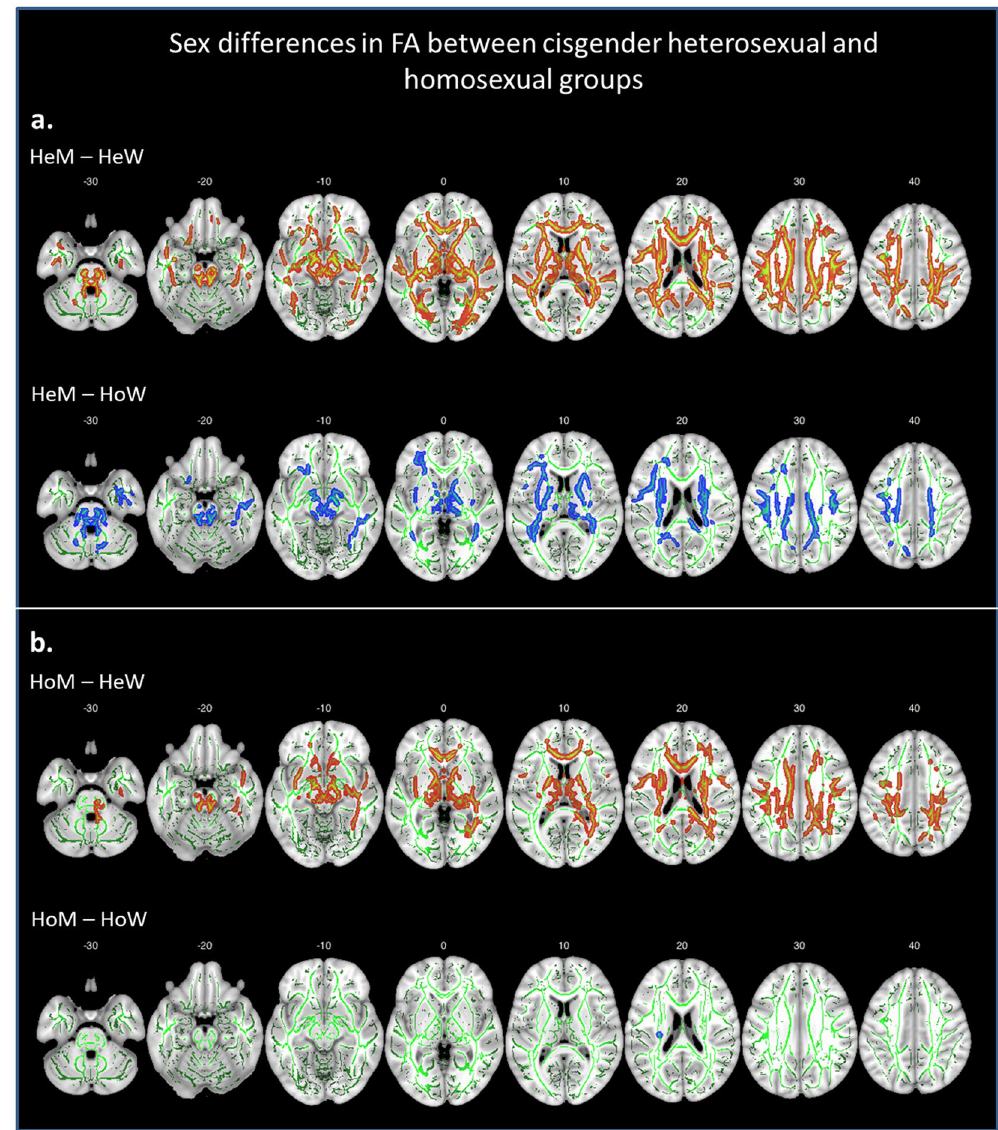
Figure 1. Whole brain voxel-wise sex differences in FA ( p < 0.05, FWE -corrected) between cisgender homosexual and heterosexual groups, projected on the mean FA skeleton (green) using the “tbss fill” procedure in FSL. Part a. shows the comparisons between heterosexual men (HeM) and heterosexual women (HeW, red), and homosexual women (HoW, blue). Part b. shows the comparisons between homosexual men (HoM) and HeW (red) and HoW (blue). Slice labels indicate MNI z-coordinates. L = left, R =